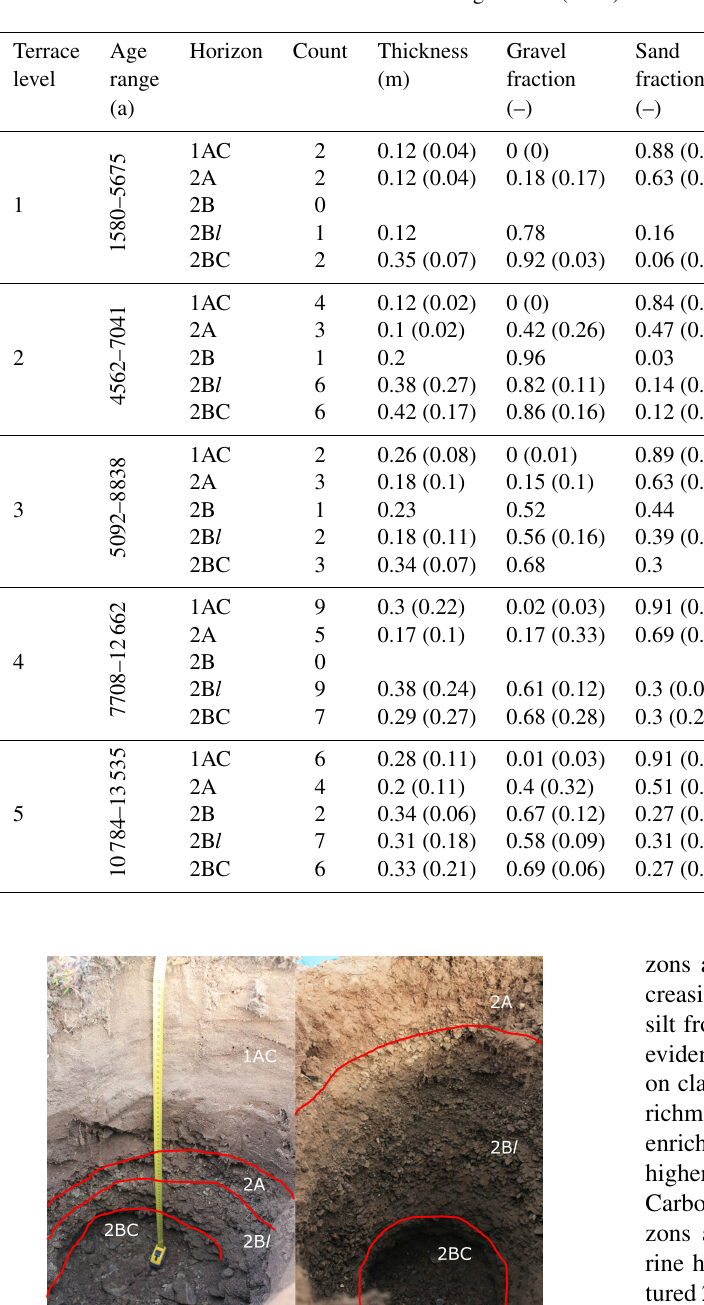
Table 3. Average and standard deviation (between brackets) of soil properties of sampled horizons. Horizons with errors in sampling were left out. Counts indicate the amount of observed horizons, the total number of samples can deviate from these numbers (see Fig. 5). The age ranges of the individual horizons were derived from the minimum and maximum altitude per terrace level and their relation with age (Fig. 3). Carbonate content was estimated in the field according to FAO (2006).